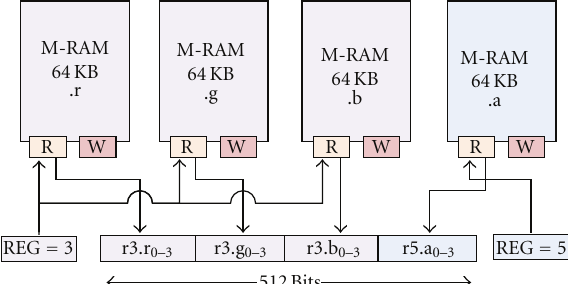
Figure 7: Mapping our register file architecture to four Stratix